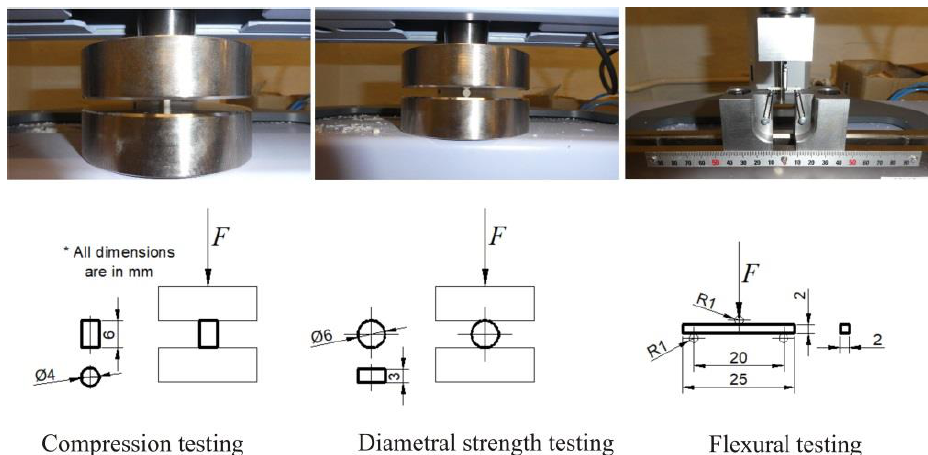
Figure 1. Schematic and actual testing of compression, diametral and flexural properties.